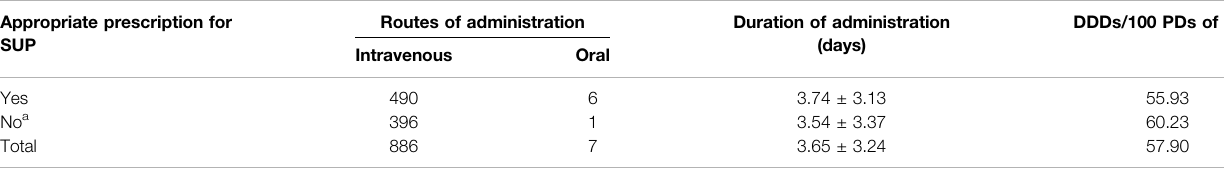
TABLE 4 | ASMs prescription patterns for SUP.